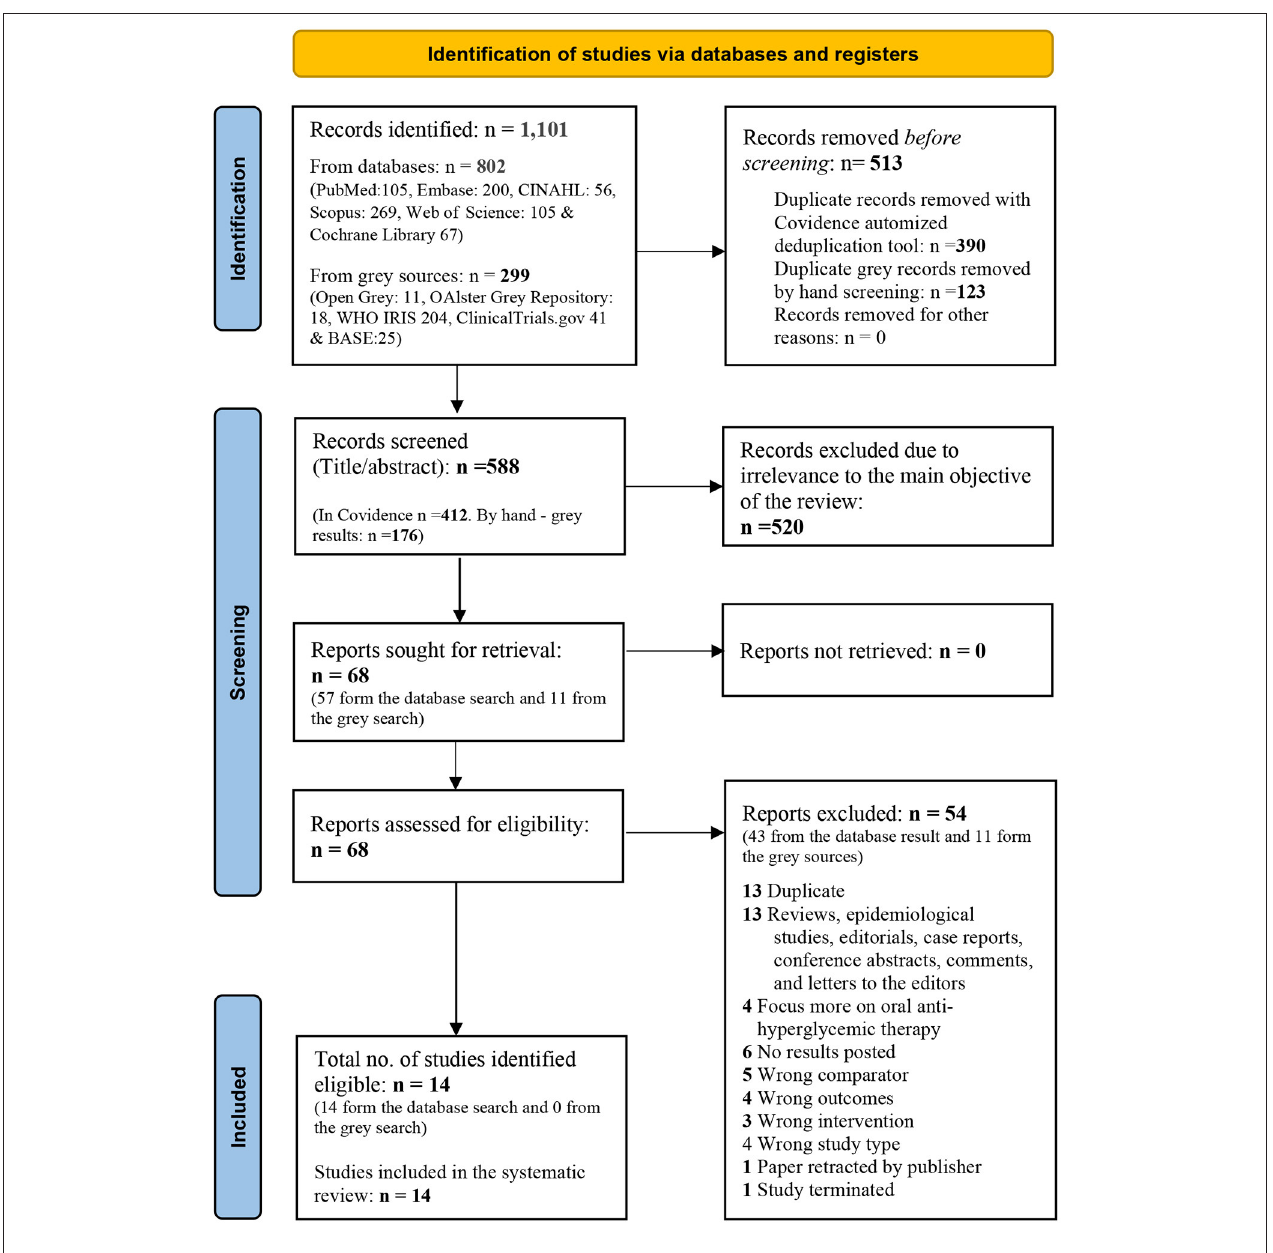
FIGURE 1 | PRISMA 2020 flow diagram for new systematic reviews which included searches of databases and registers only. From: Page et al. (14). For more information, visit: